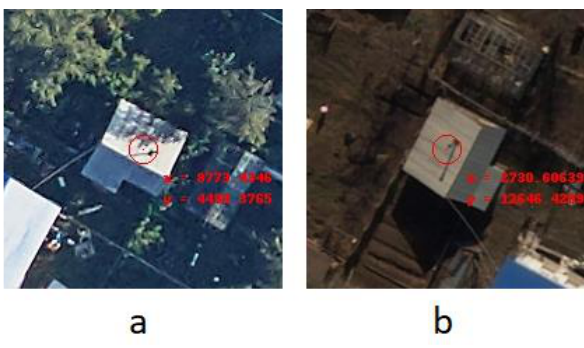
Figure 10. An example of a tie point in different years images (a – PhaseOne IXA180, b – DMC II